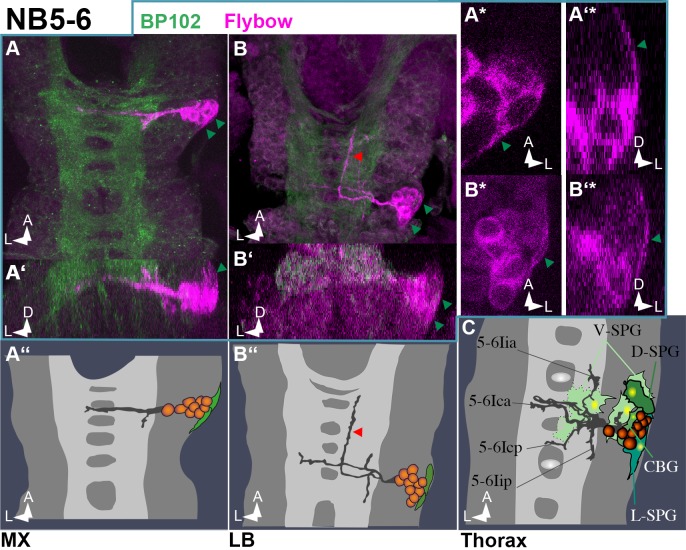
NB5-6 lineage in gnathal segments.Frontal (A´, B´, A´* and B´*) and horizontal (all other) views of Flybow clones (semischematic drawings in A´´, B´´ and C and composite confocal stacks in all other images) resembling NB5-6 lineage. In thoracic segments (C) NB5-6 is a neuroglioblast that gives rise to about 5 glial cells and several interneurons that project through both commissures and form short axons along the ipsilateral connective in both directions [14]. Although Flybow clones generated with an Elav driver are expected to show only low hue-expression in glial cells, the clones reveal a couple of cells at the cortex margin with glial-like shape (green arrowheads in the confocal images and green cells in A´´ and B´´); A* to B´* zoom into single layers of the image stacks in A and B to show the typical morphology of subperineural glial cells: in a location directly at the margin of the nerve chord with long and thin protrusions that cover the cortex. The projection pattern of the LB lineage largely resembles the thoracic one, but shows an additional long ipsilateral projection in anterior direction (red arrowhead in B and B´´). In MX the lineage shows reduced projections.